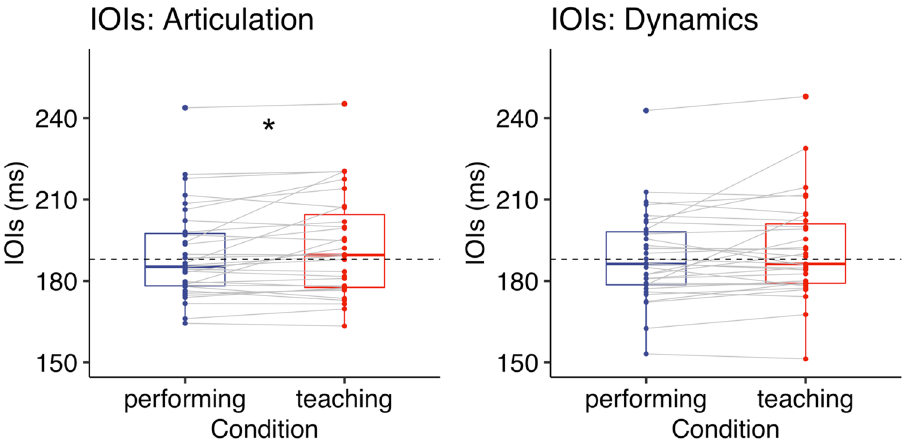
Figure 2. Experiment 1: IOIs (ms) when playing the piece with either articulation (left) or dynamics (right). A dashed line represents the tempo given by a metronome. Each box indicates the IQR with the median, and whiskers extend to a maximum of 1.5 × IQR beyond the box. Significance levels: * < 0.05, ** < 0.01, *** < 0.001.